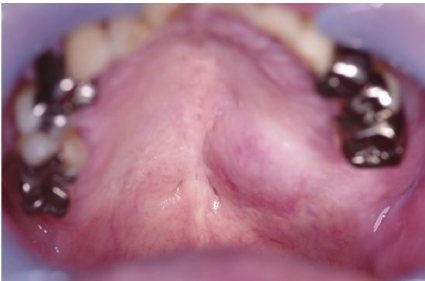
Figure 1: Intraoral findings at the first visit.